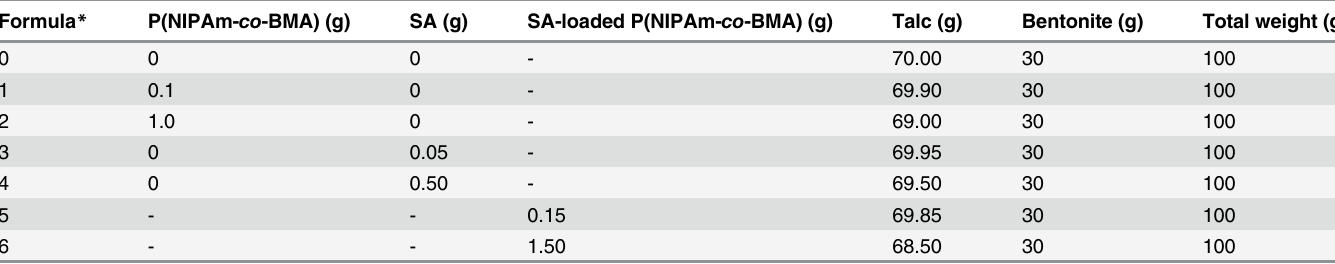
Table 1. Formulas of the maize seed-coating